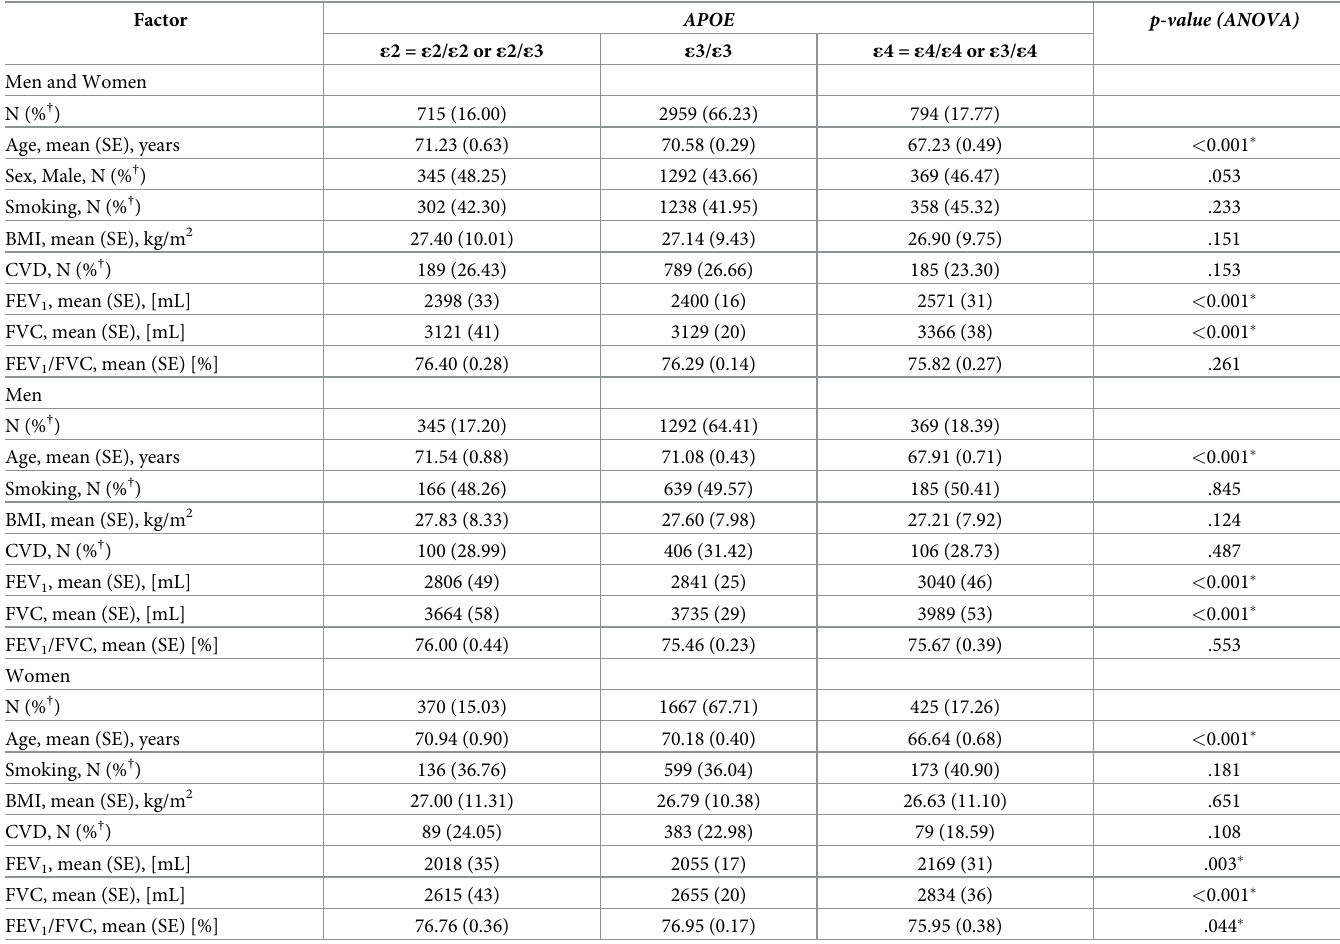
Table 1. Baseline demographic characteristics and outcomes used in the analyses of the genotyped LLFS participants for men and women combined and separately.